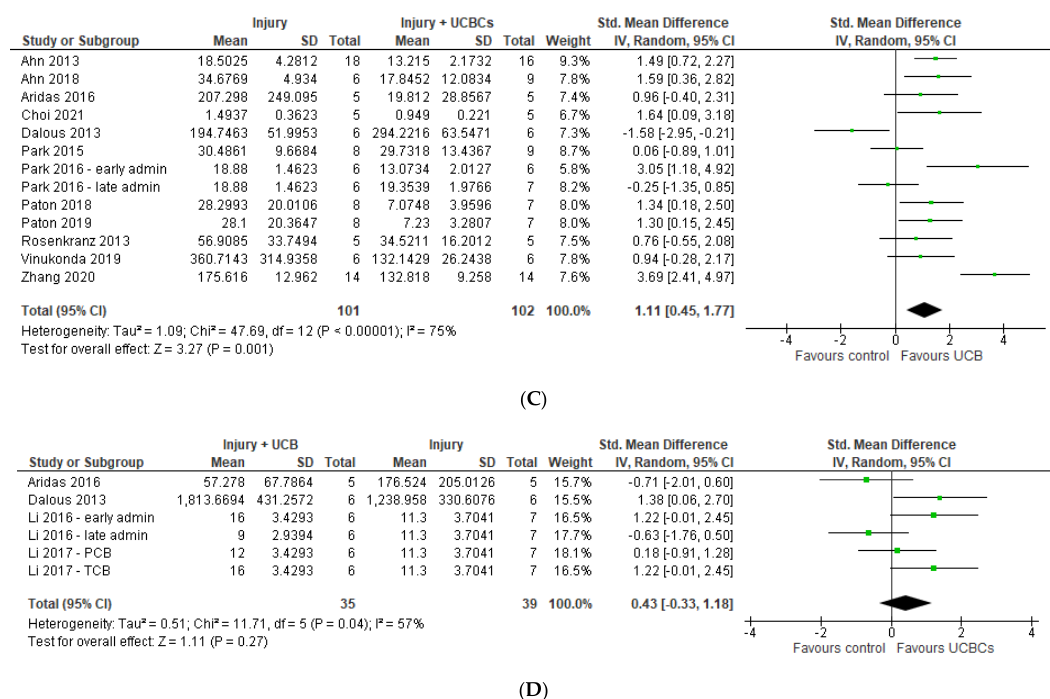
Figure 4. Forest plot demonstrating the effect of umbilical cord blood-derived cell therapy on neuroinflammation ( A ) TNF- α ; ( B ) IL-6; ( C ) IL-1 β ; ( D ) IL-10. Umbilical cord blood-derived cell therapy significantly decreased neuroinflammation as measured by TNF- α ( p < 0.0001), IL-6 ( p < 0.01) and IL-1 β ( p = 0.001). Abbreviations: admin, administration; ICV, intracerebroventricular; IV, intravenous; PCB, preterm cord blood; TCB, term cord blood; UCBC, umbilical cord blood cells.